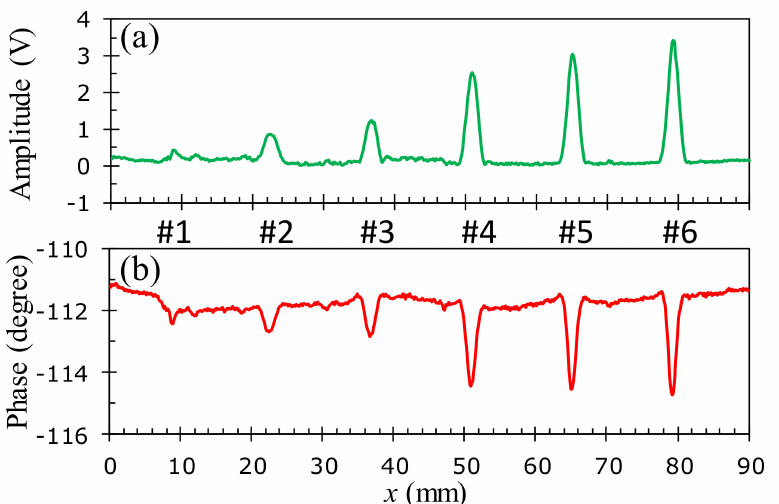
Figure 18. Inspection of cracks buried at h = 0.285 mm at the 30 kHz optimal excitation frequency on an aluminum specimen: ( a ) amplitude variation, ( b ) phase angle